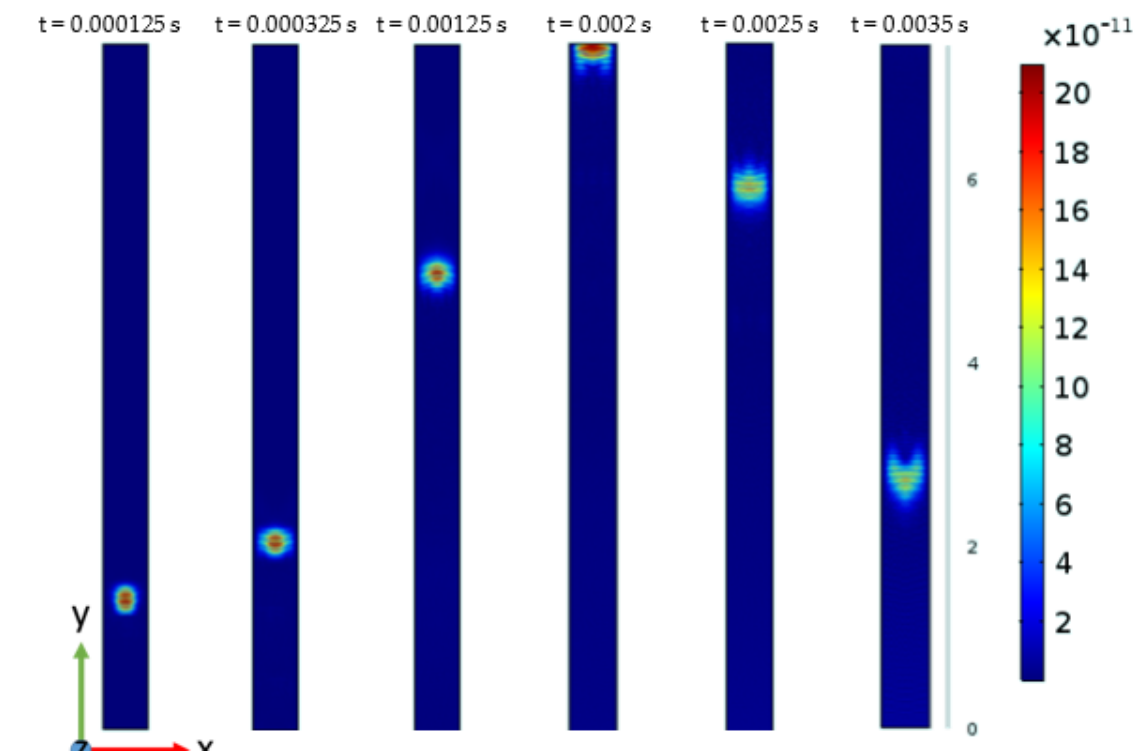
Figure 13. Shear wave propagation in the plate with the same cross-sectional area as the web of the U-pile.